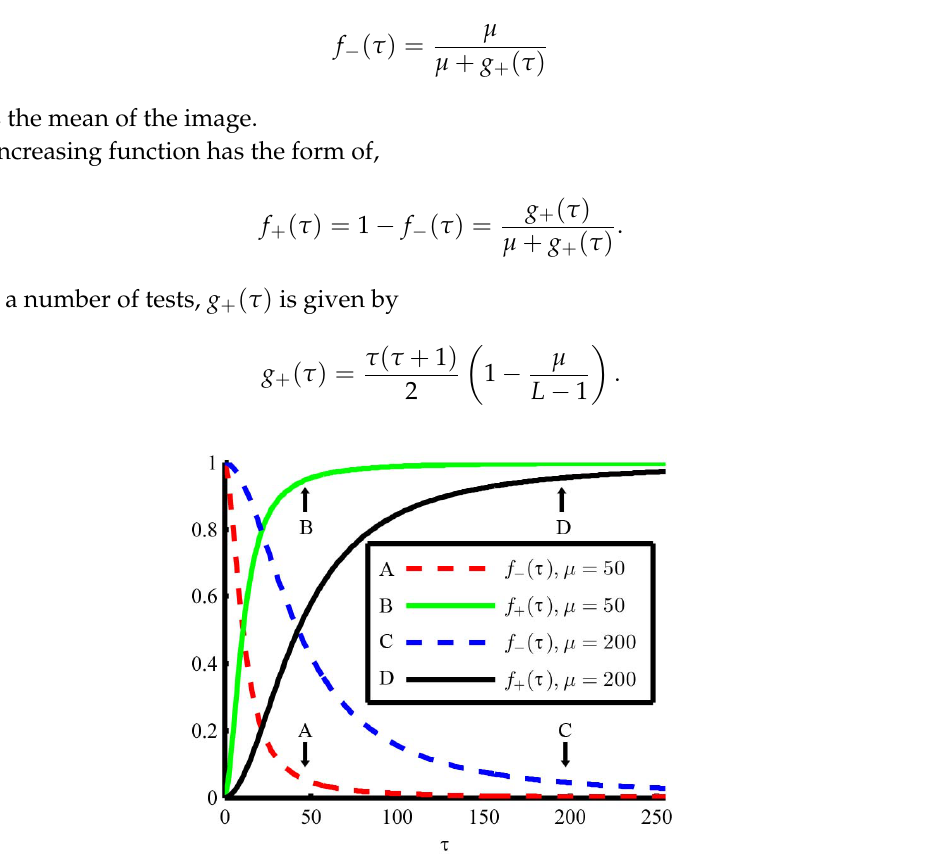
Figure 1. Posterior probabilities functions f − ( τ ) and f + ( τ ) with different parameters µ